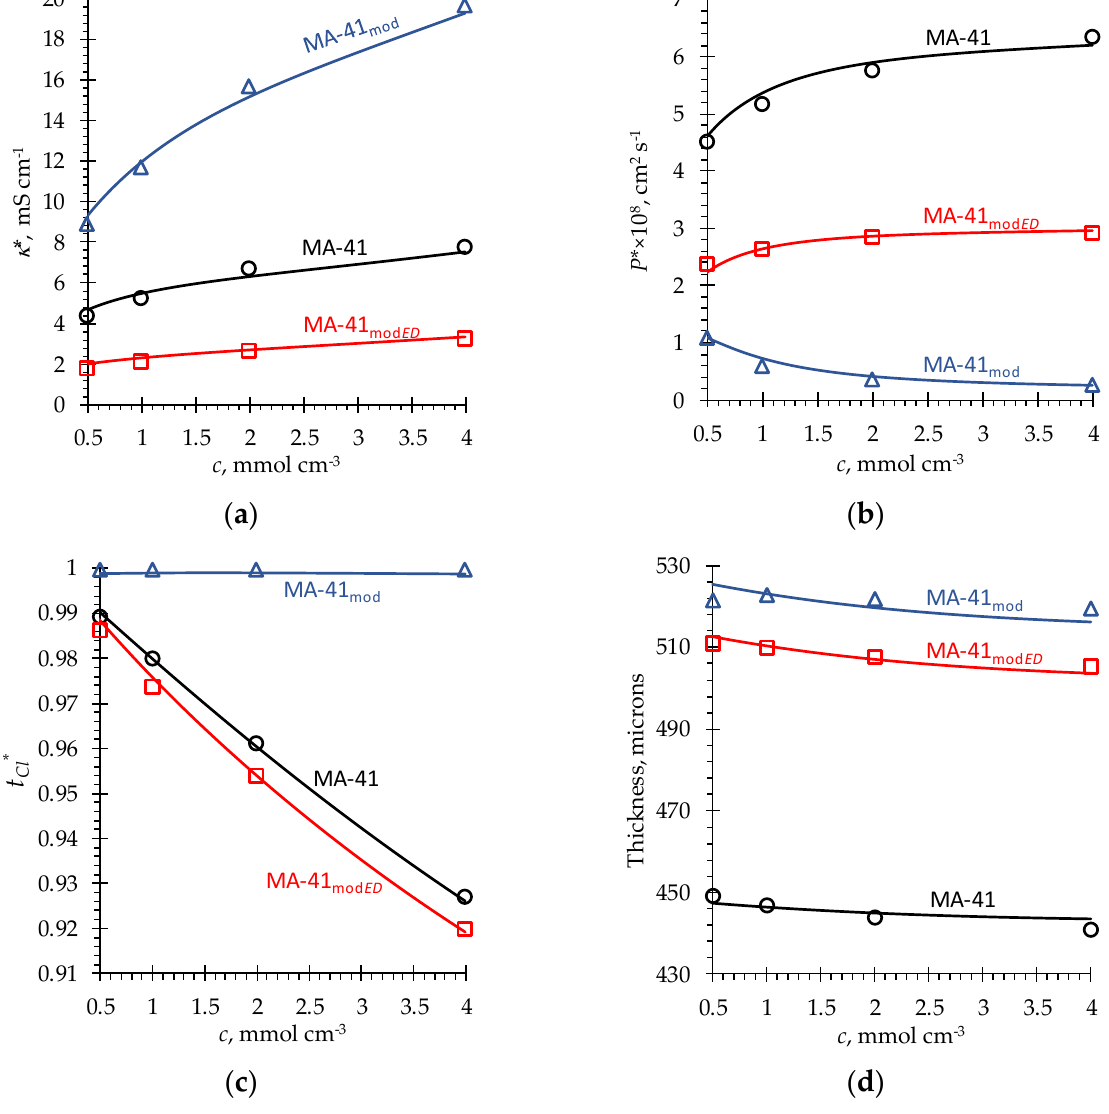
Figure 6. Experimental (markers) and simulated (solid lines) concentration dependencies of ( a ) elec- tric conductivity, ( b ) diffusion permeability, ( c ) counterion, Cl − , transport number and ( d ) thickness of MA-41, MA-41 mod and MA-41 mod ED membranes (indicated near the corresponding curve). As noted above, some input parameters ( α (cid:48) , D ) and some output parameters ( κ *, i P *, t Cl *, thickness, q wb , q w , f 2 m eso ) are functions of the bathing solution concentration c